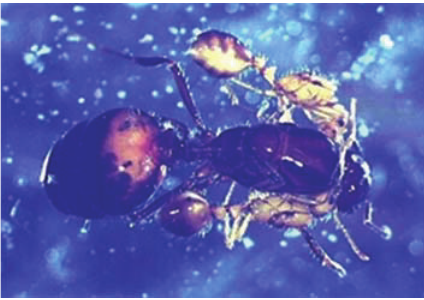
Figure 9: Two queens of Solenopsis daguerrei yoking a queen of Solenopsis richteri